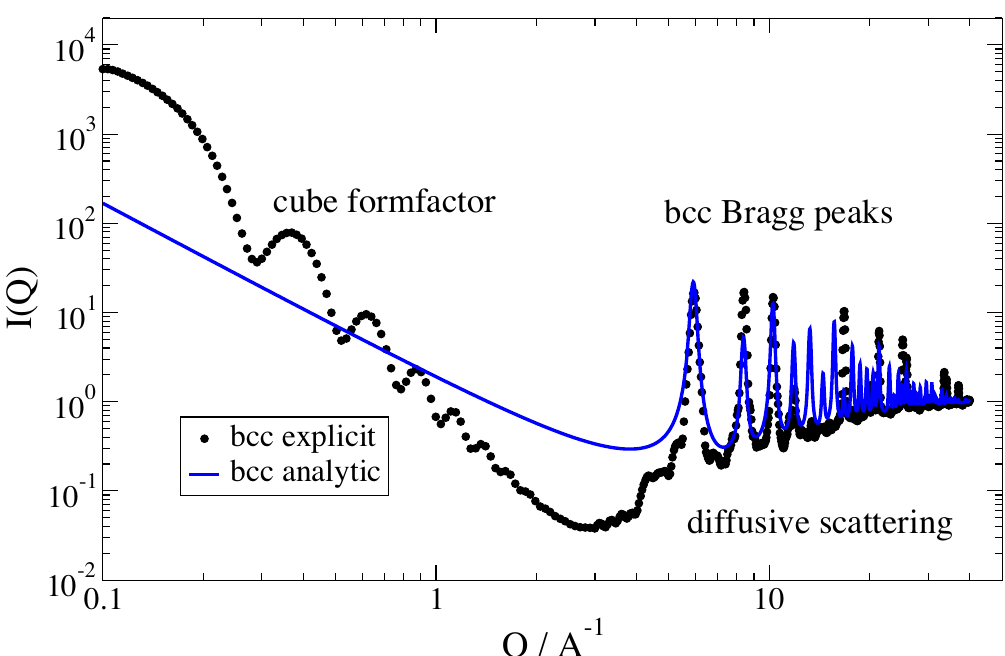
Fig 4. Comparison of analytical structure factor model with an explicit calculation for a bcc lattice in cubic shape of same dimension. At Q = 5 A -1 we observe the onset of the (100) peak of the respective simple cubic lattice, which is forbidden in a bcc lattice. At low Q we observe the form factor of the crystal shape as a